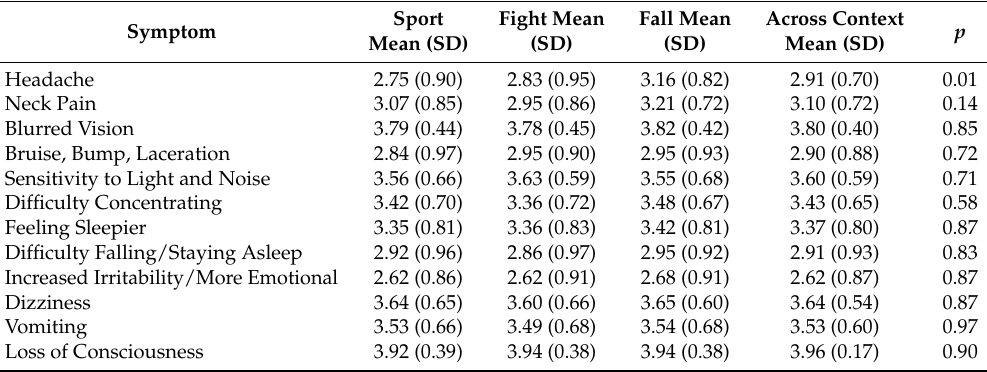
Table 2. Average intention to seek medical treatment score by symptom.